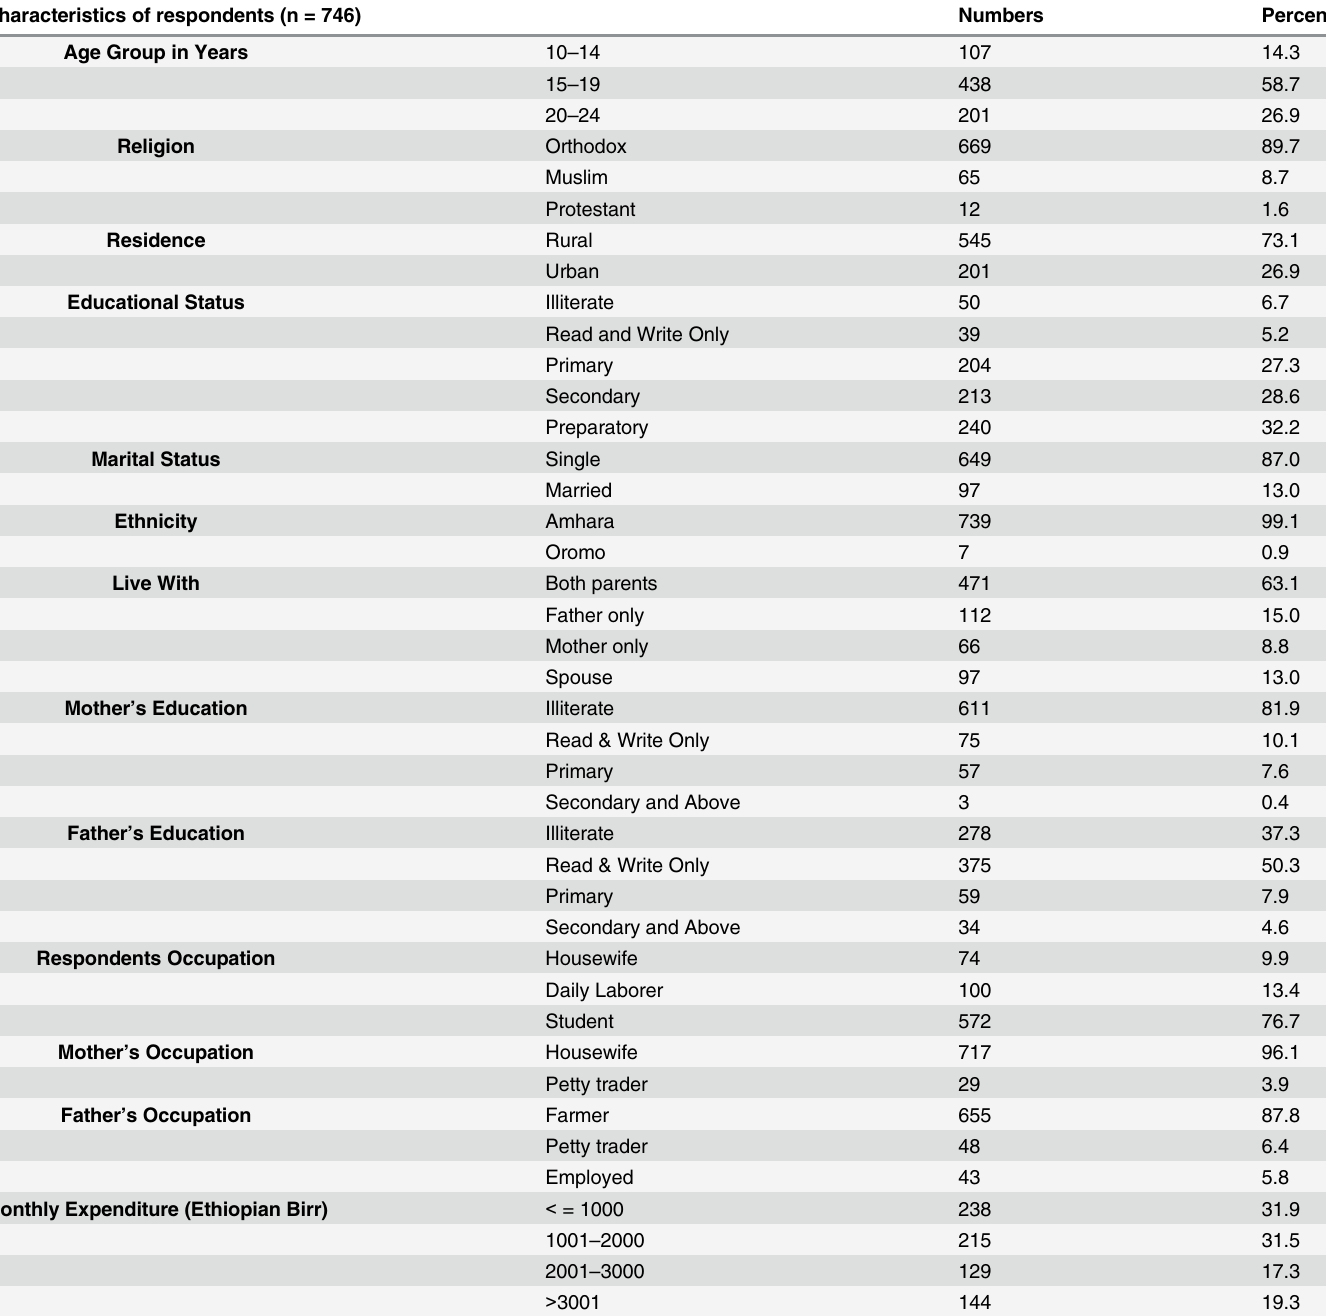
Table 1. Socio-demographic characteristics of Young People in Northwest Ethiopia, 2015. Characteristics of respondents (n =